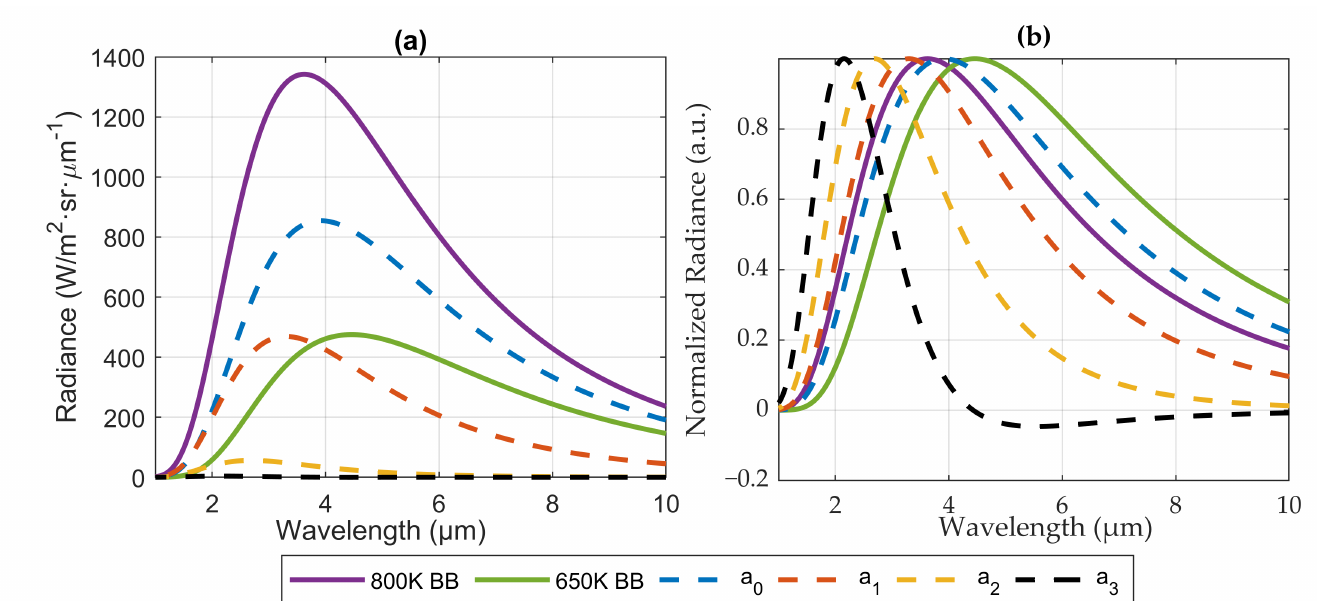
Figure 1. ( a ) Spectra of the first Fourier amplitudes of the radiance of a blackbody source whose temperature oscillates sinusoidally between T = 650 K and T = 800 K, compared to the blackbody spectra. ( b ) The same spectra of ( a ),